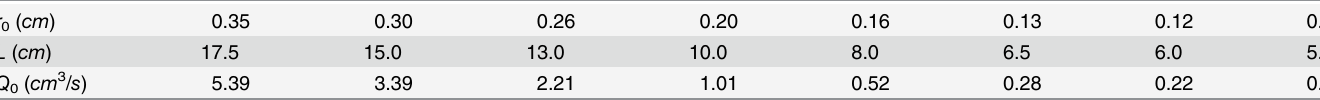
Table 1. The geometrical data and the mean flow rate used in the single artery